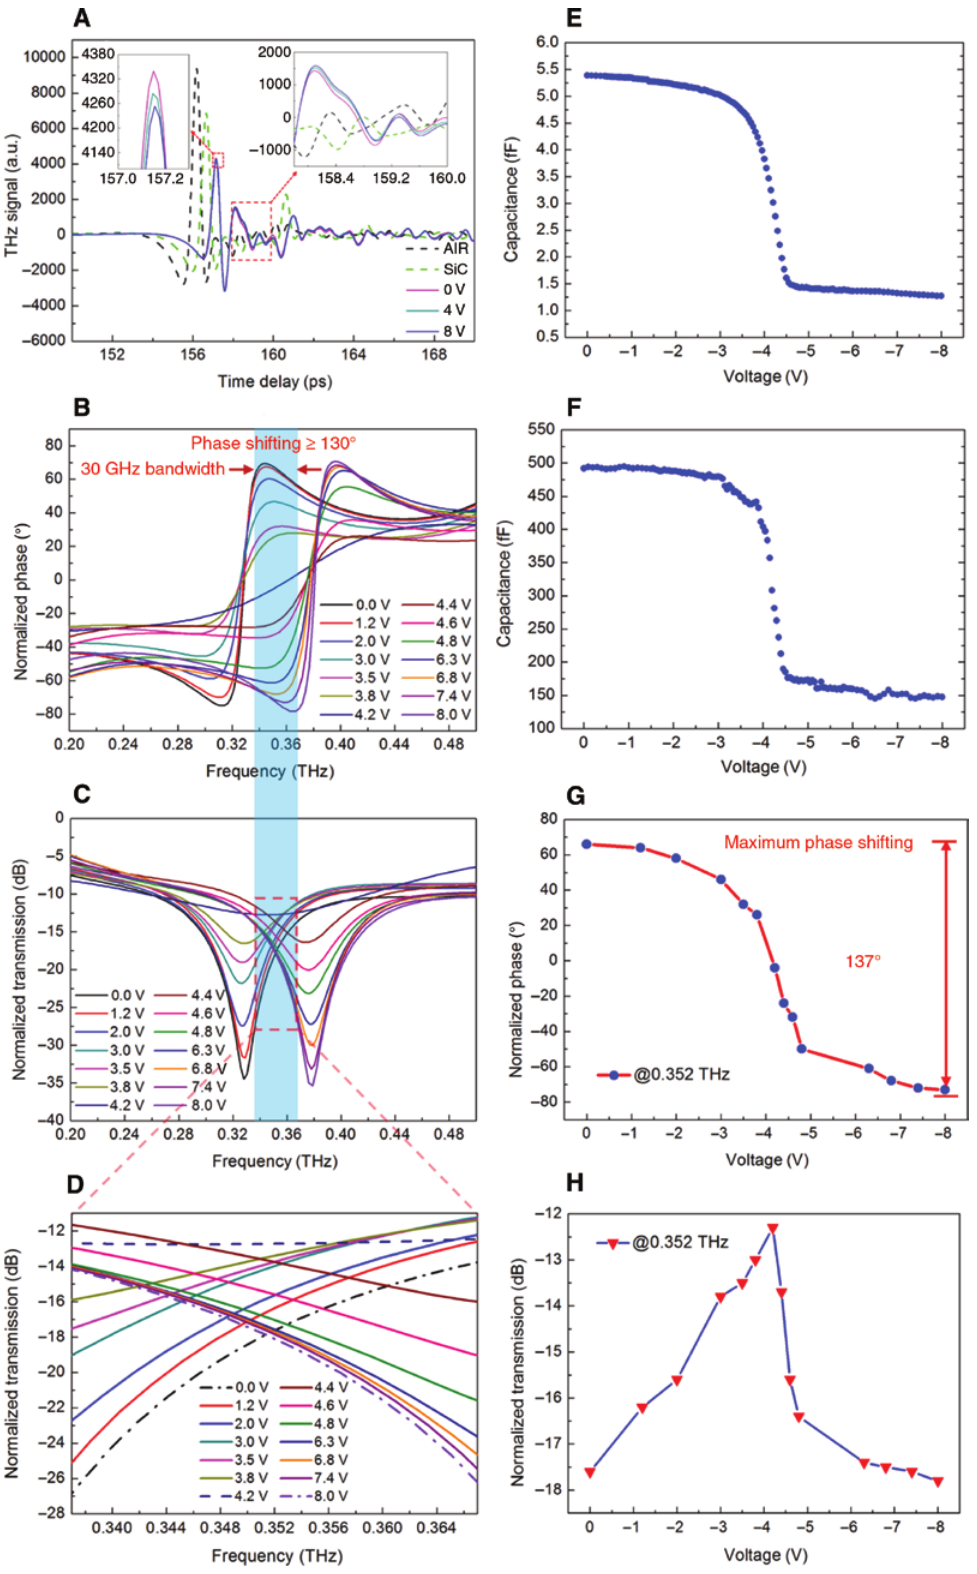
Figure 8: THz experimental results with the variation of voltages: (A) original time-domain data of TDS with different voltages, (B) phase shift with different voltages, (C) transmission spectrum with different voltages, (D) transmission spectrum in working band, (E) C-V relation of a single HEMT, (F) C-V relation of an array, (G) phase shift at 0.352 THz with different voltages, and (H) transmission at 0.352 THz with different